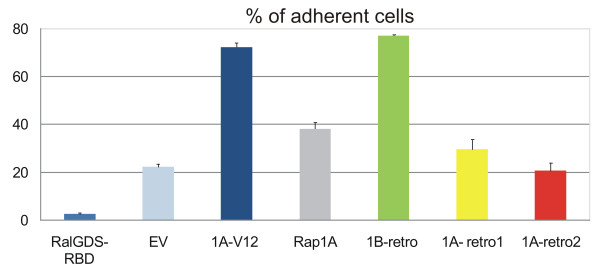
Analysis of the effect of mRap1A-retro1, -retro2 and hRap1B-retro on cell adhesion. Jurkat cells stably expressing Epac (HB6 cells) were co-transfected with TK luciferase reporter plasmid and either empty vector (EV) or Rap1 constructs as indicated. After 42 h cells were replated and seeded in triplicate wells coated with fibronectin and after 1 h the percentage of adherent cells was measured. Results are representative of three independent experiments. The expression of HA-Rap and HA-RalGDS-RBD was determined by Western blotting using anti-HA as a probe (data not shown).